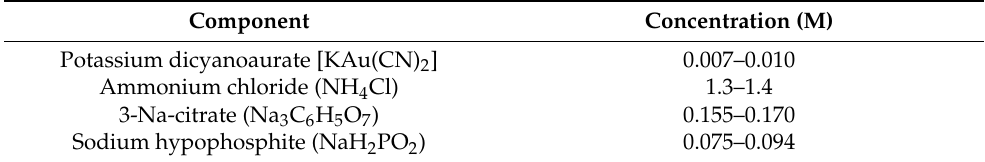
Table 4. Laboratory-developed electroless gold bath composition. Adapted with permission